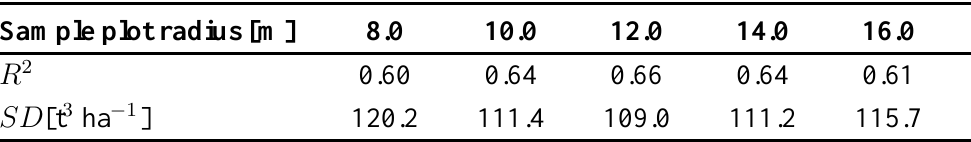
Table 2. Determination of the optimum circular sample plot size by analyzing various radii according to their R 2 and standard deviation of the